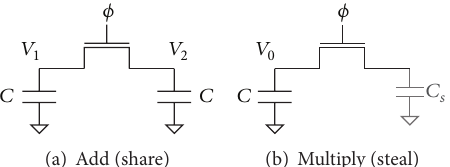
Figure 9: Techniques for charge domain addition and multiplica- tion